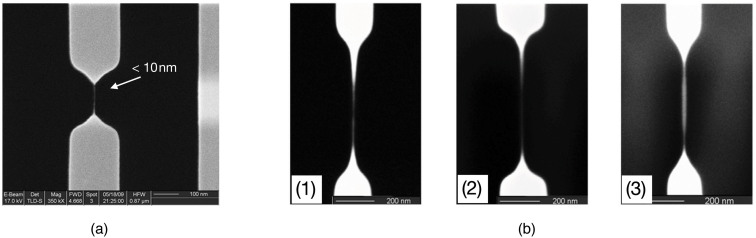
(a) Sub-10 nm nanostring was formed on Si3N4 cantilever. (b) Comparison experiments to demonstrate the mechanism. For certain material, (b1) and (b2) are the comparison of different ion energy irradiations, which are 15 keV and 30 keV respectively, with the same flux of 3.1 × 1017 ion·cm−2. (b3) and (b2) are the comparison of different ion flux irradiations, which are 3.1 × 1017 ion·cm−2 and 1.5 × 1018 ion·cm−2 respectively, with the same energy of 30 keV.